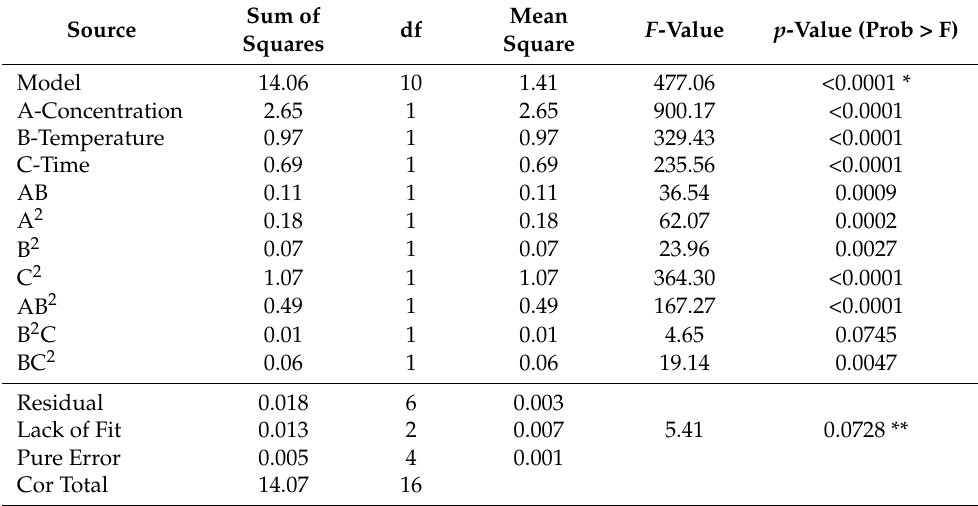
Table 6. ANOVA for the amount of Al 3+ ions eluted from alumina ceramics after exposure to nitric